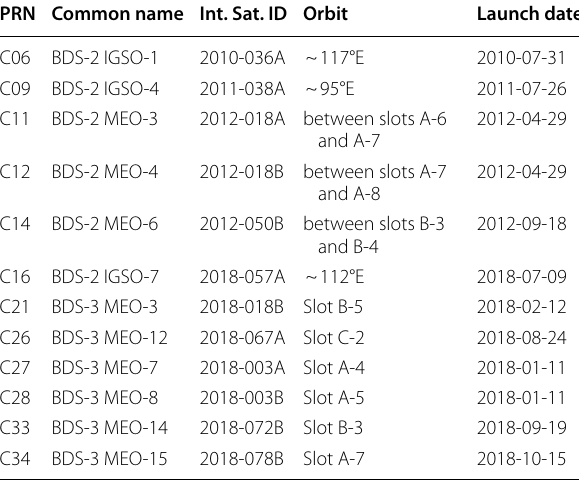
Table 2 Details of BDS-2 and BDS-3 satellites received by the Huawei Mate 20 PRN Common name Int. Sat. ID